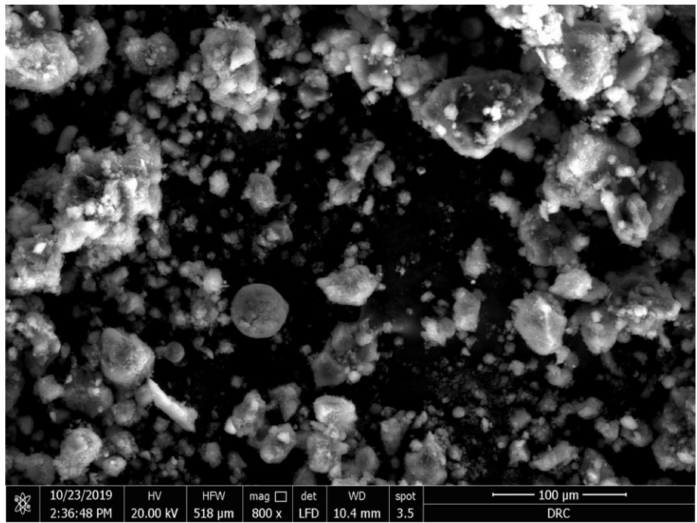
Figure 4. SEM image of the sulfonated tire polymer char (TPC-SO 3 H)